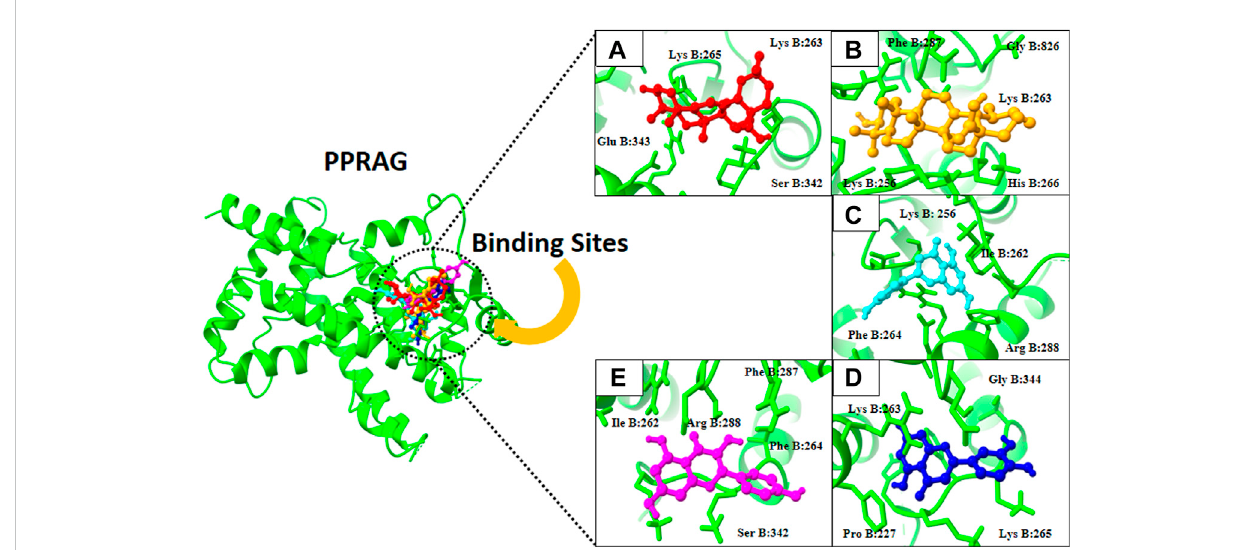
FIGURE 5 3D visualization of PPRAG protein with active compounds: (A) Kaempferol, (B) ursolic acid, (C) apigenin, (D) oleanolic acid, and (E) luteolin.